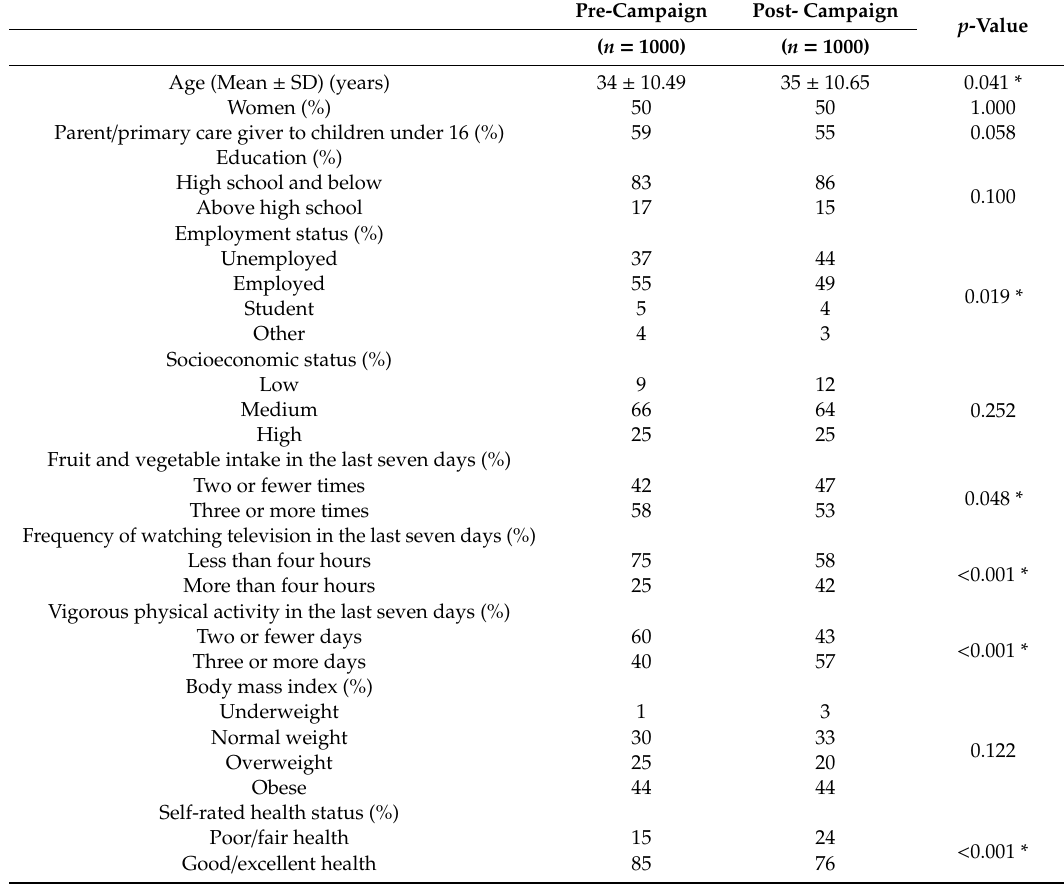
Table 1. Demographic characteristics of final study sample in the pre- and post-campaign periods. Pre-Campaign Post-